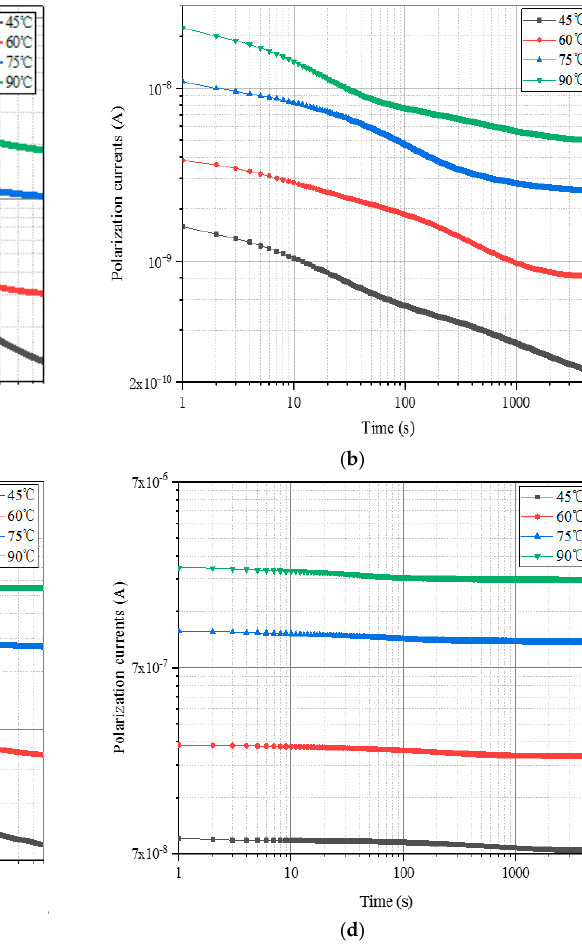
Figure 2. The polarization currents of unaged polymer pressboards with various moisture contents at different test temperatures. ( a ) mc% = 0.81%, ( b ) mc% = 1.56%, ( c ) mc% = 2.62%, ( d ) mc% = 3.84%.